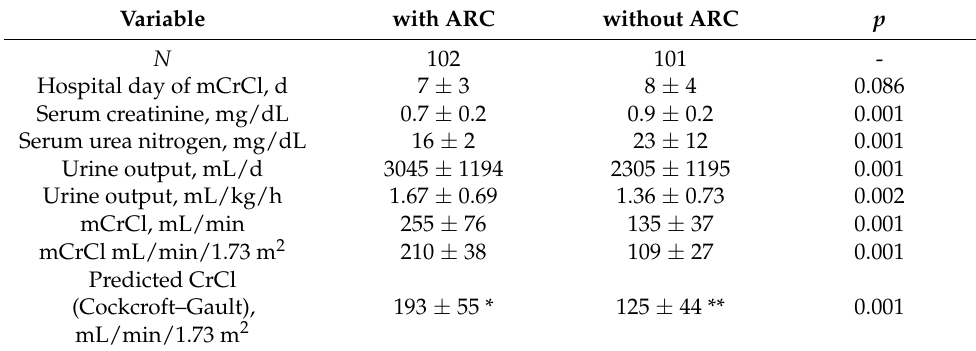
Table 4. Renal function and measured creatinine